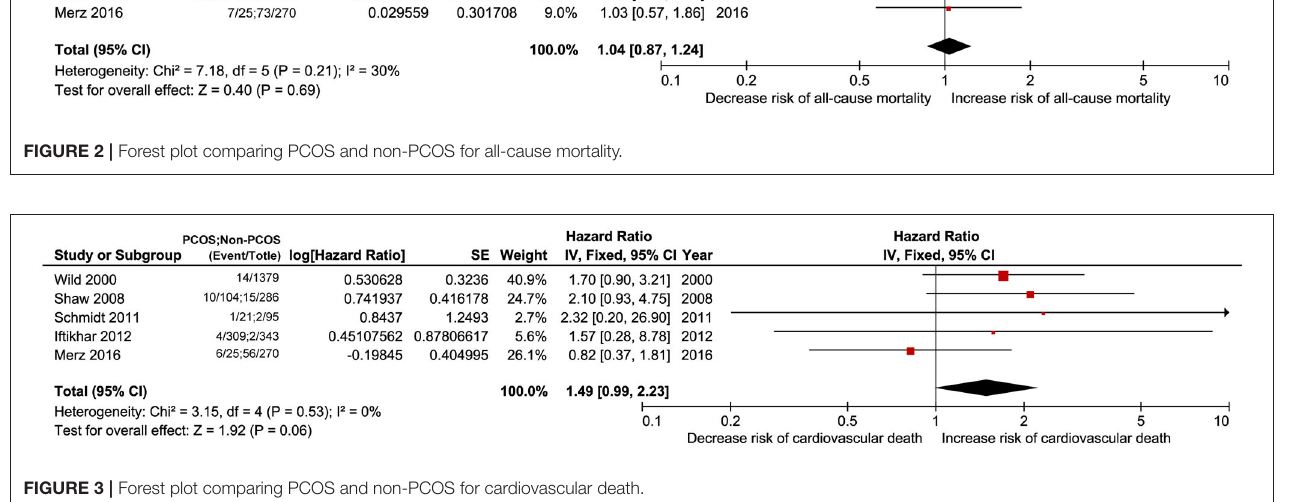
FIGURE 3 | Forest plot comparing PCOS and non-PCOS for cardiovascular death.